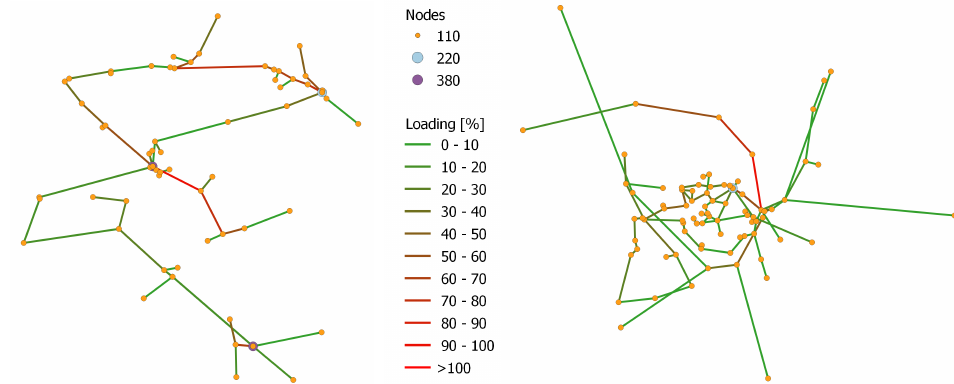
Figure 4. Line loadings in the “lW” study case of the mixed ( left ) and the urban ( right ) HV grid.